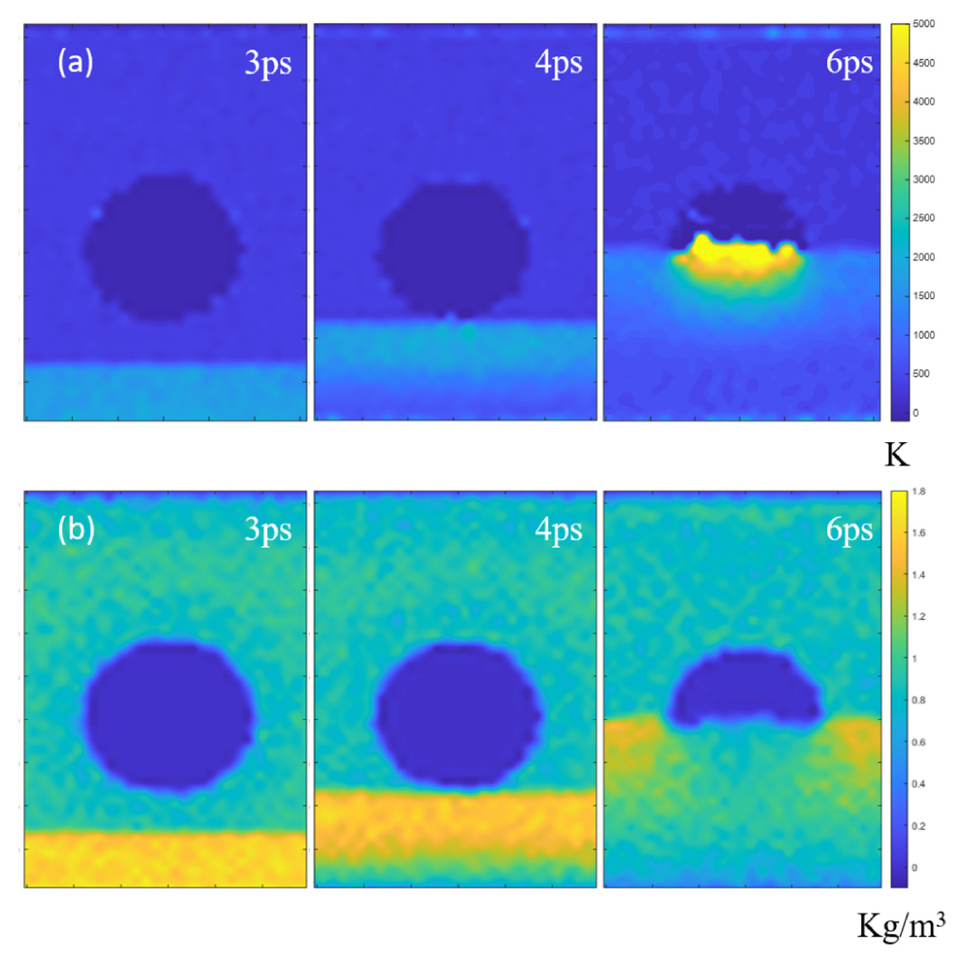
Figure 4. ( a ) The temperature contour and ( b ) the liquid density contour of the vacuum nanobubble system during a nanobubble collapse process.